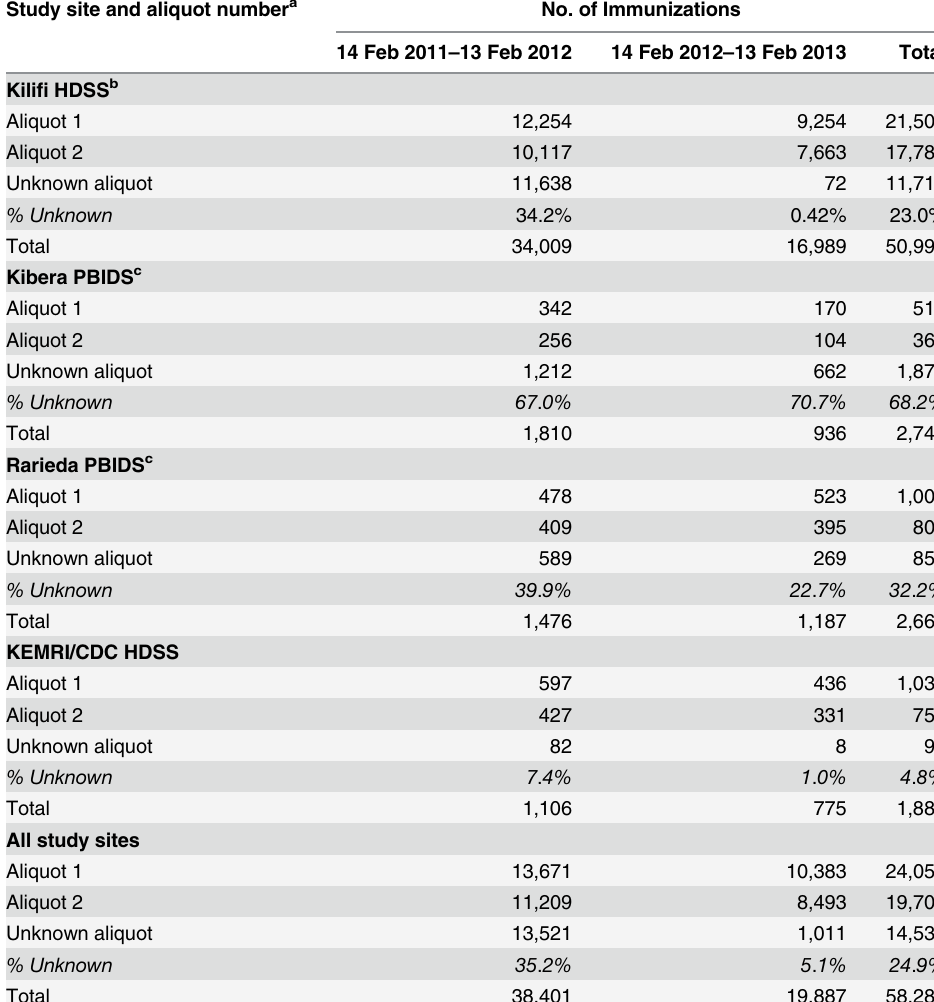
Table 2. Number of pneumococcal conjugate vaccine (PCV10) immunizations administered to infants in VAEIK study sites according to aliquot number, Kenya, 14 February 2011 – 13 February 2013.